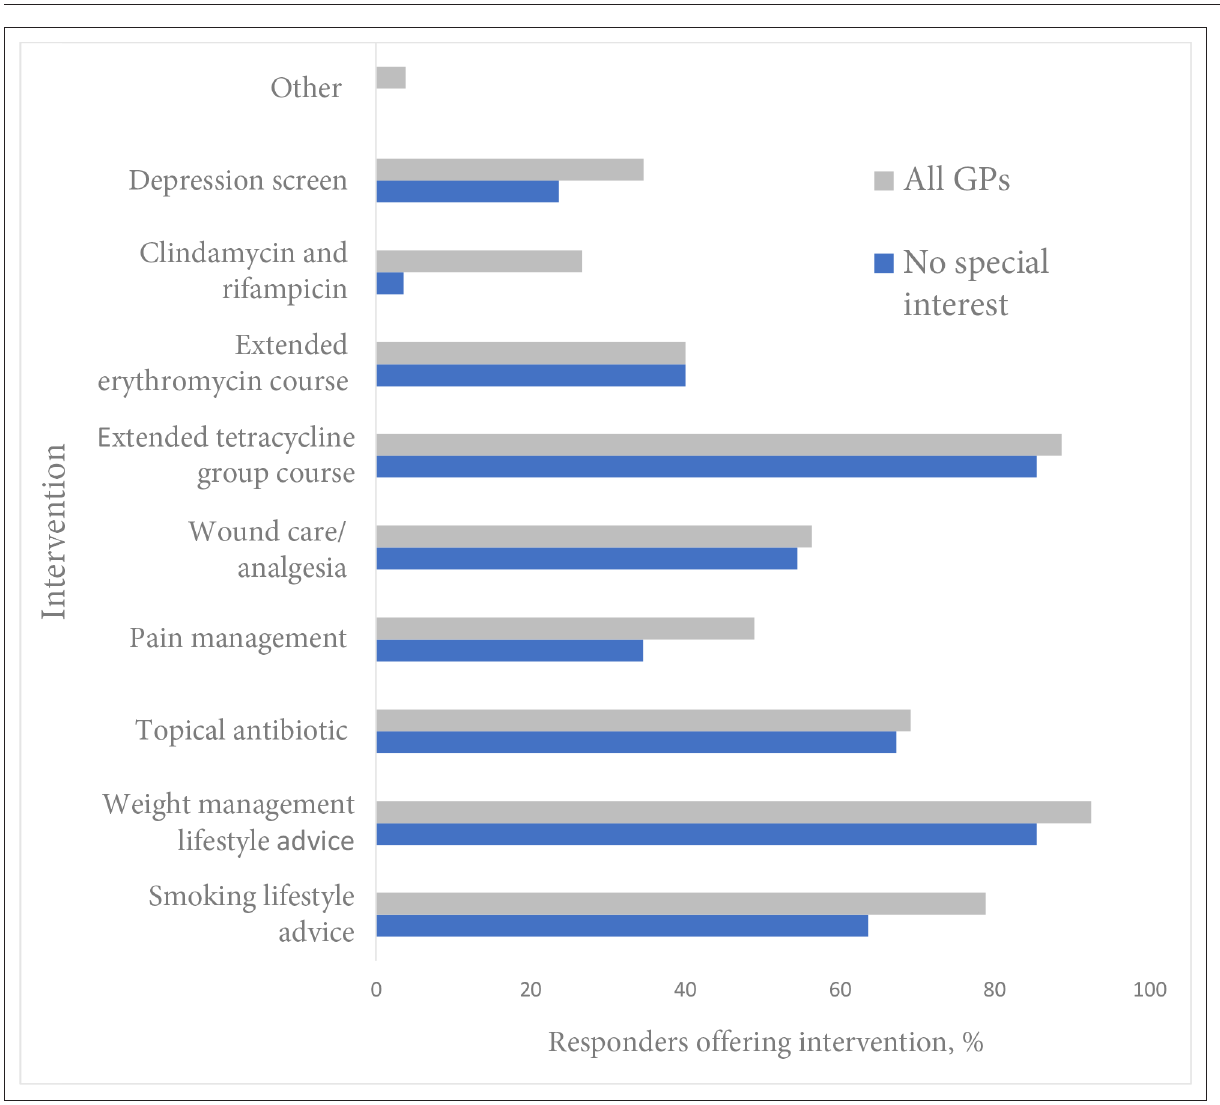
Figure 1 Medical interventions for hidradenitis suppurativa. GPs choice of options for what they would try before referral, comparing overall GP sample with subgroup of GPs with no dermatology special interest. Other = free - text replies: metformin, ‘botox’, isotretinoin, comorbidity